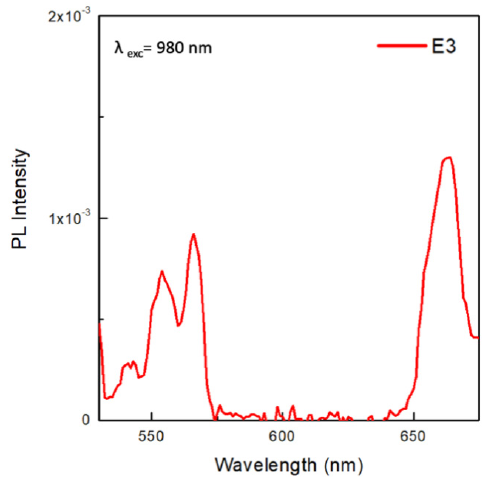
Figure 5. Upconversion spectrum of the Er:Y 2 O 3 NPs sample E3 ( λ exc = 980 nm).